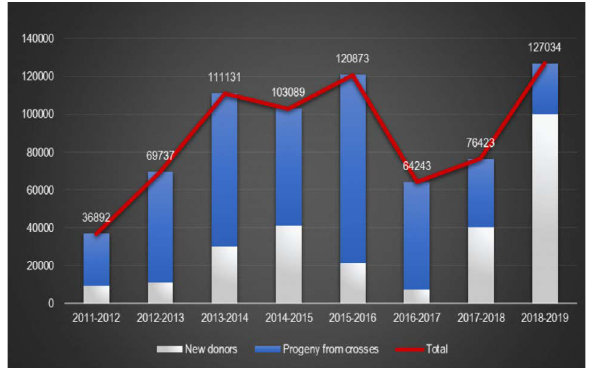
Figure 5: Number of data points generated since inception of the marker- assisted selection programme.